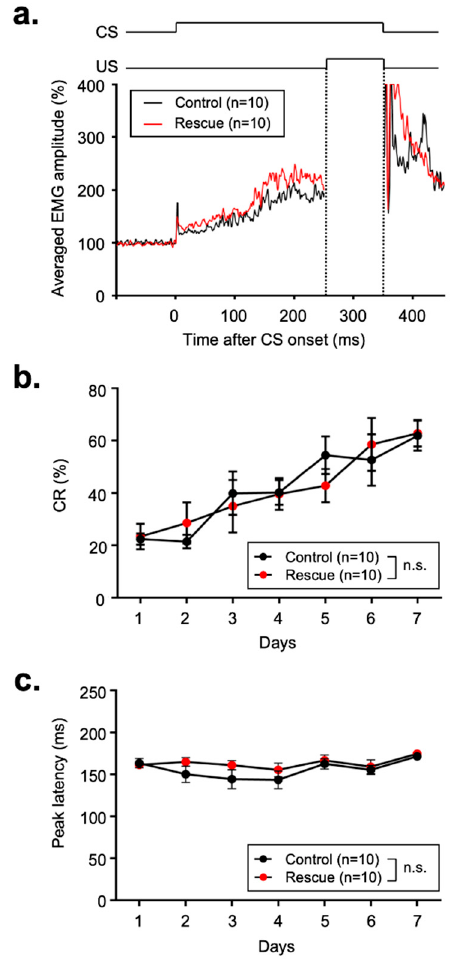
Figure 4. ( a ) Temporal relationship between the CS and US in eyeblink conditioning. A temporal overlap of the US with the preceding CS can be observed. The averaged EMGs of control mice and mGluR5-rescue mice were imposed under the CS-US time course. ( b ) CR acquisition as a motor learning curve in the control mice and mGluR5-rescue mice. In the acquisition session of day 1 to day 7, daily session consisted of 10 blocks of trials, with each block consisting of nine CS–US paired trials. ( c ) CR peak latency during the eyeblink conditioning in the control and mGluR5-rescue mice. In this analysis, we used mGluR5-rescue High mice. Data are expressed as mean ± SEM. n.s., not significant. Table 1. The comparison of eyeblink conditioning parameters between control and mGluR5-rescue mice.